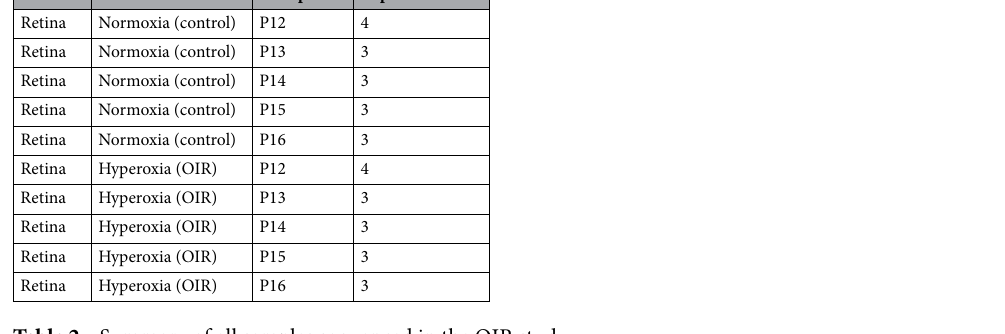
Table 2. Summary of all samples sequenced in the OIR